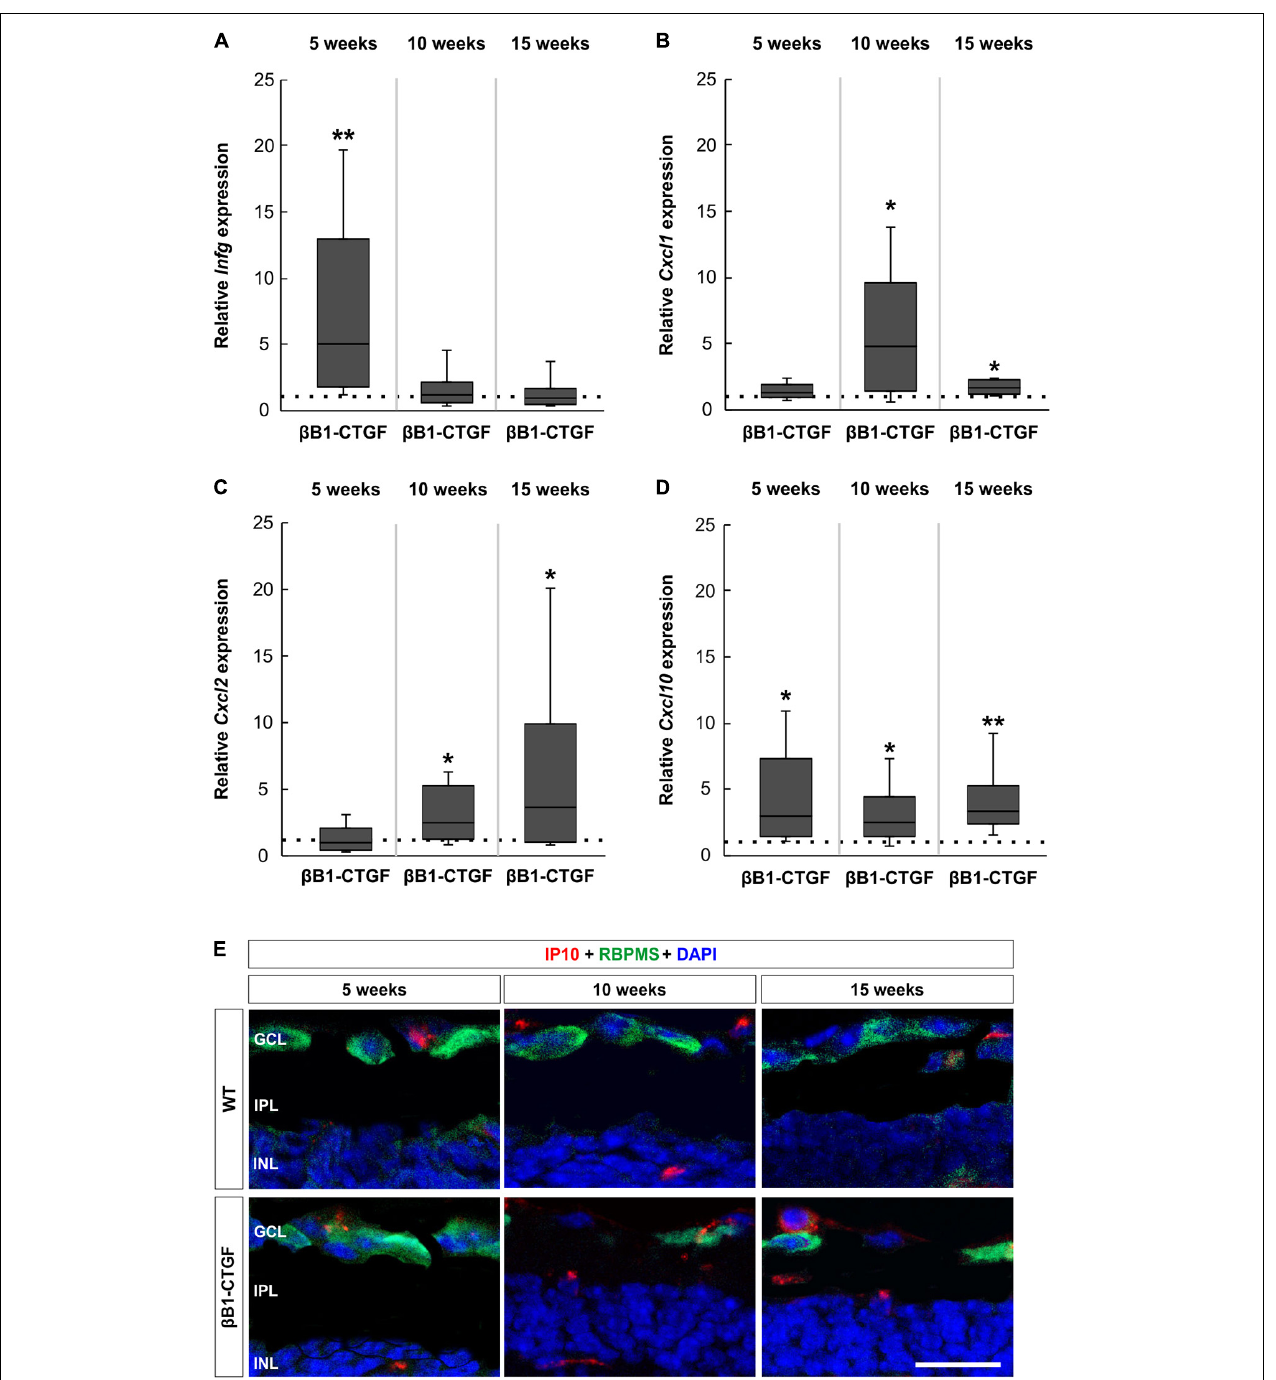
FIGURE 6 | Upregulated cytokine expression in β B1-CTGF retinae. (A) RT-qPCR analyses showed an upregulation of Infg mRNA levels in β B1-CTGF retinae at 5 ( p = 0.009), but not at 10 and 15 weeks of age. (B) The mRNA expression levels of Cxcl1 were not altered in 5-week-old transgenic mice. At 10 and 15 weeks, significantly higher mRNA levels of Cxcl1 were noted in β B1-CTGF mice (10 weeks: p = 0.01; 15 weeks: p = 0.04). (C) RT-qPCR analyses revealed no changes in the mRNA expression levels of Cxcl2 in 5-week-old transgenic animals. A significant upregulation of Cxcl2 mRNA levels was noted in β B1-CTGF mice at 10 ( p = 0.03) and 15 weeks ( p = 0.04). (D) Cxcl10 mRNA levels were significantly upregulated in β B1-CTGF retinae at 5 ( p = 0.03), 10 ( p = 0.02), and 15 weeks ( p = 0.002). (E) Representative pictures of retinal cross-sections labeled with an antibody against IP-10 (CXCL-10; red) and RBPMS (RGCs; green), while DAPI counterstained cell nuclei (blue). IP-10 + cells were predominantly observed in the ganglion cell layer and inner nuclear layer of β B1-CTGF mice. Values are median ± quartile ± minimum/maximum ( n = 5–6/group). The dotted line in panels (A–D) represents the relative expression of the WT group. GCL, ganglion cell layer; IPL, inner plexiform layer; INL, inner nuclear layer. Scale bar: 20 µ m. * p < 0.05, ** p < 0.01.